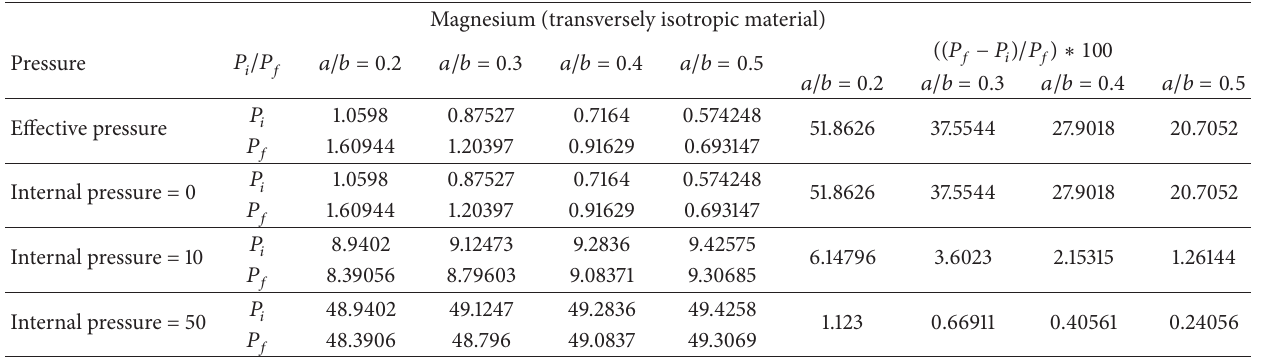
Table 4: The pressure required for initial yielding and fully plastic state for transversely isotropic material (magnesium). Magnesium (transversely isotropic material)